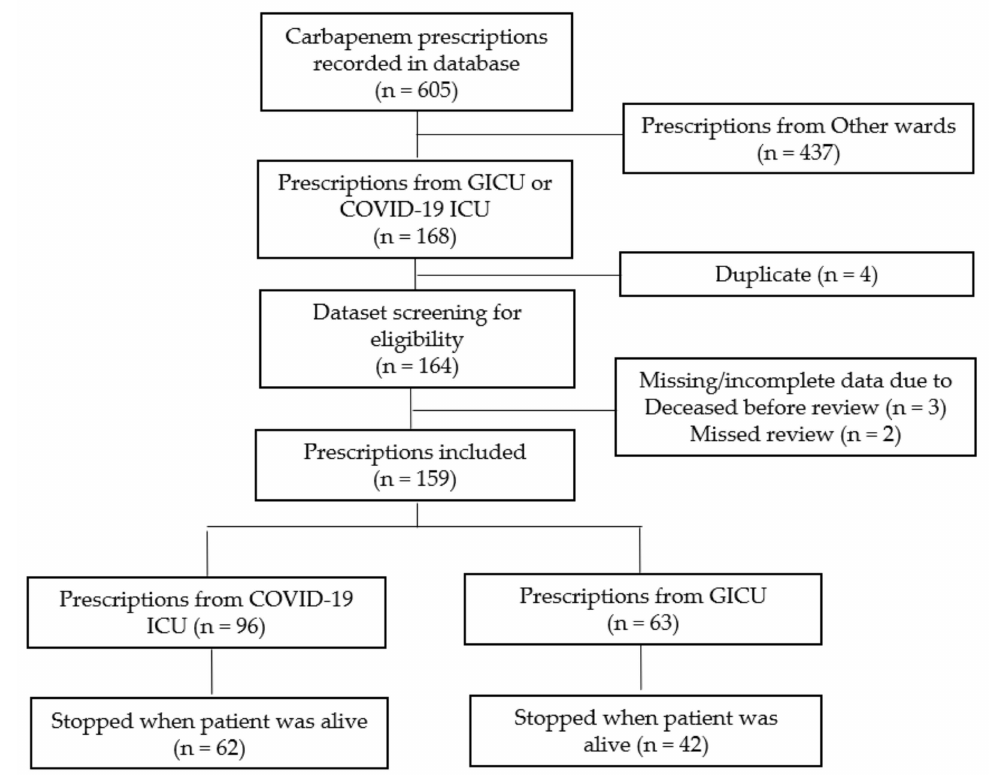
Figure 2. The selection process for eligible carbapenems prescriptions.